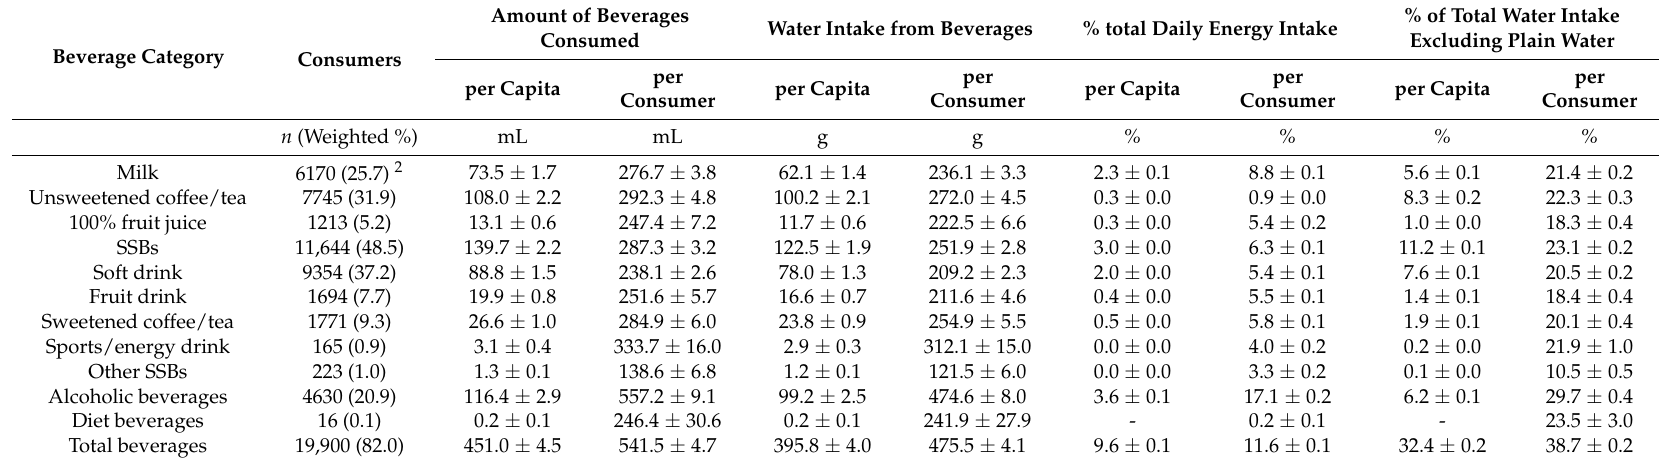
Table 2. Water and energy intakes from beverages among Korean adults, KNHANES 2008–2012 1